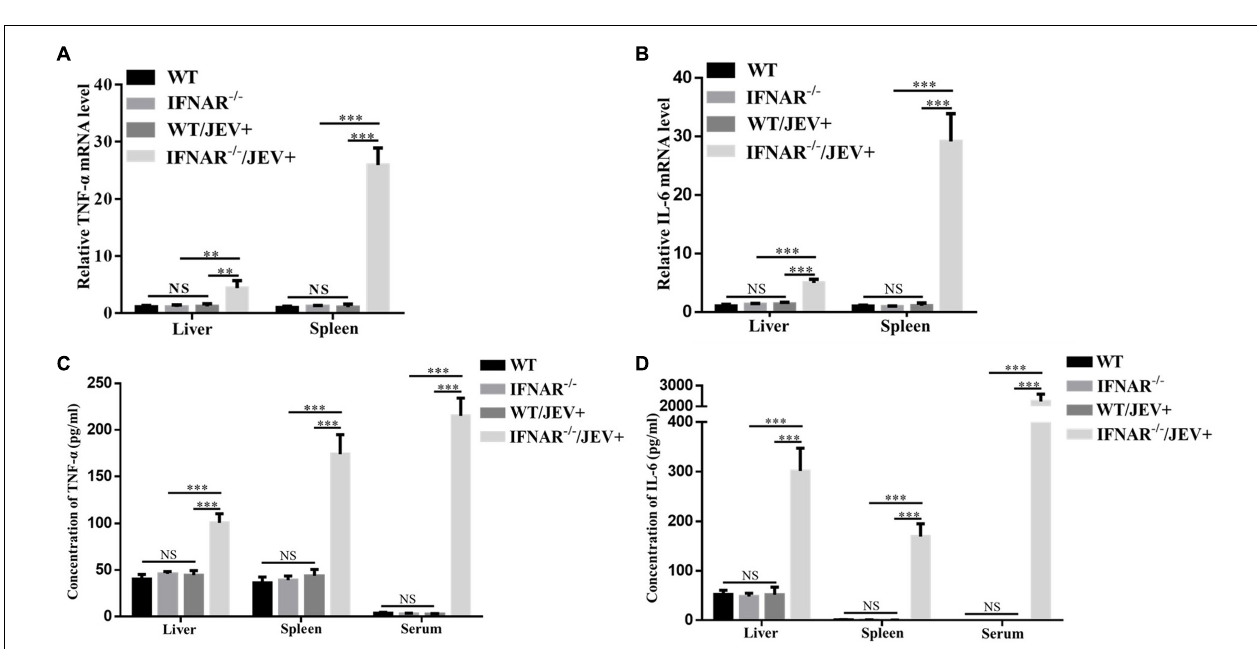
FIGURE 4 | Effects of IFNAR deficiency on the IFN-I pathway after JEV vaccine strain SA14-14-2 infection. (A,B) Corresponding protein levels of IFN- α and IFN- β in each organ with significant viral replication and serum were measured by ELISA. The mRNA expression levels of ISGs in the liver (C) and spleen (D) were measured by using real-time PCR. All the data represent mean ± SD of biological triplicates from at least three independent experiments. The Student’s t -test performed statistical analyses. ∗ P < 0.05, ∗∗ P < 0.01, ∗∗∗ P < 0.001. NS, no significance. N/D, not detectable.